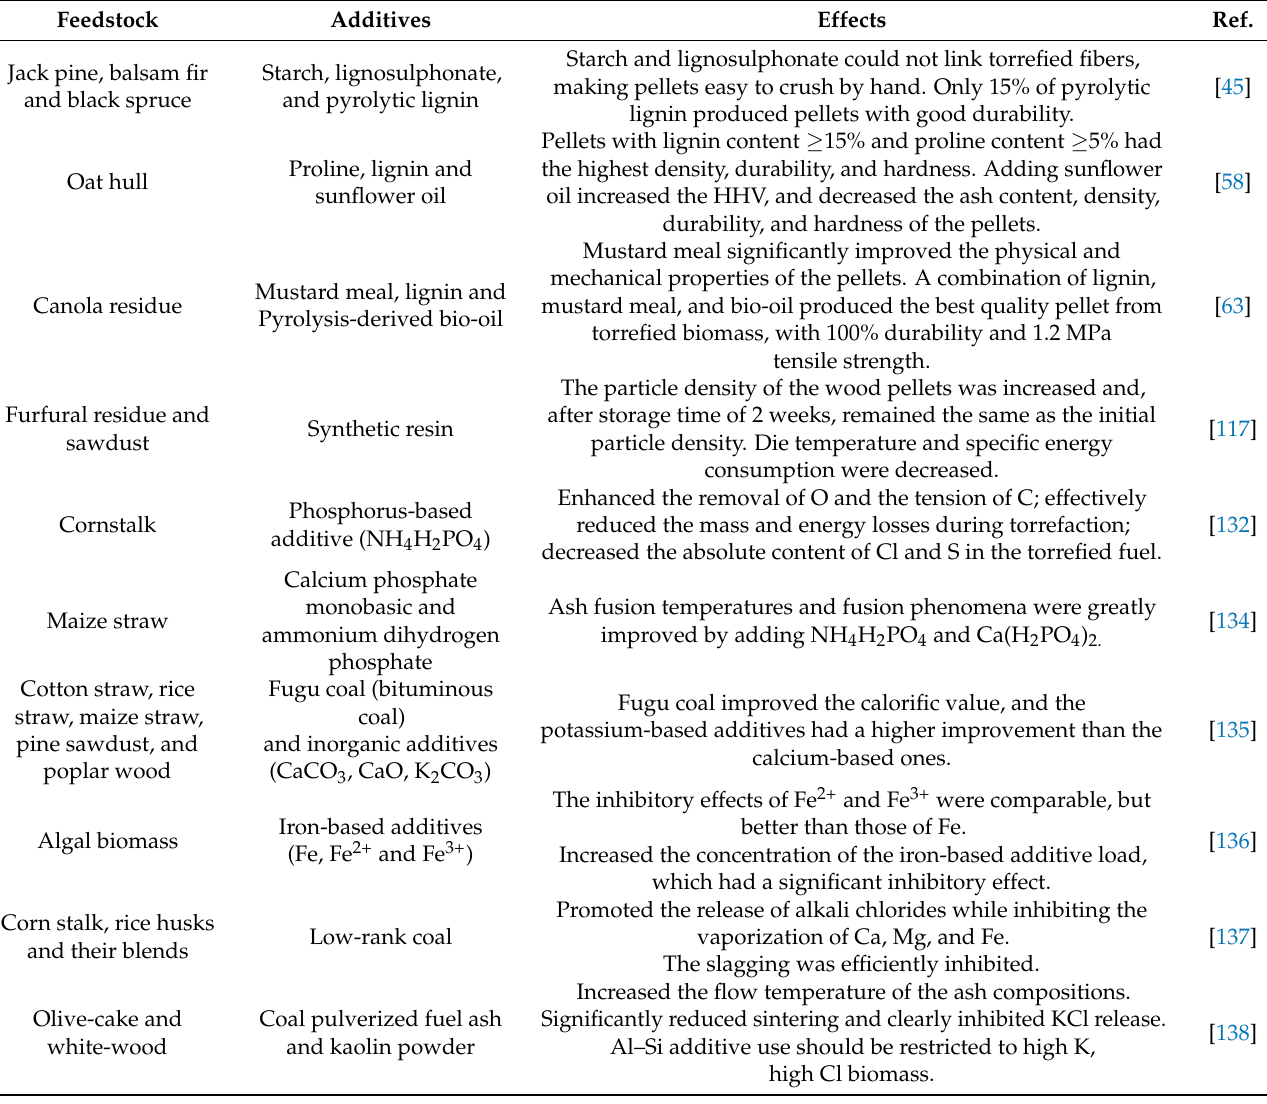
Table 2. Effects of additives on